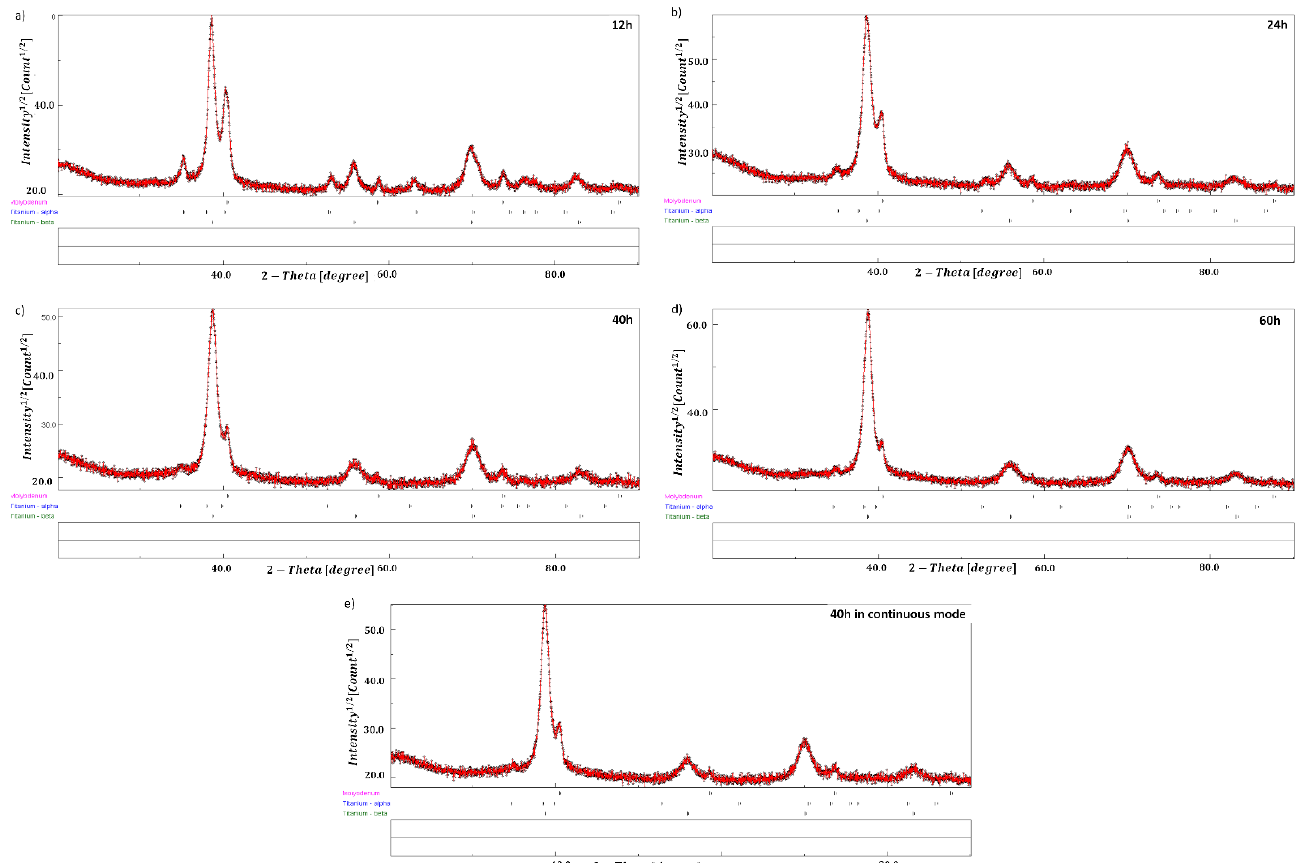
Figure 1. MAUD fits for powders milled at ( a ) 12 h, ( b ) 24 h, ( c ) 40 h, ( d ) 60 h and ( e ) 40 h in continuous mode.